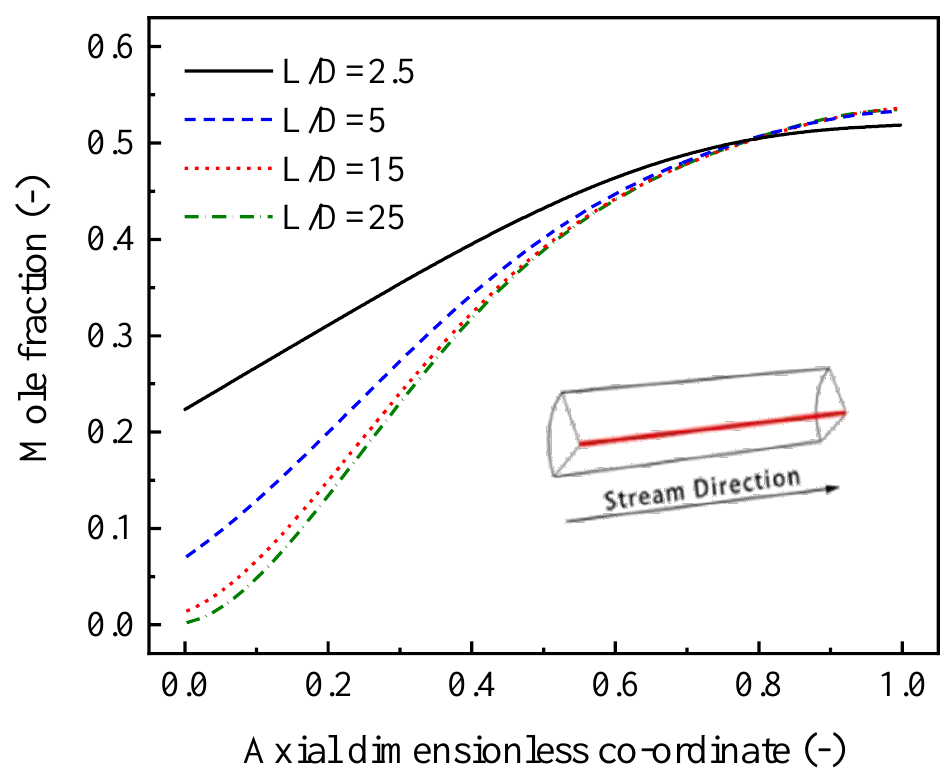
Figure 14. Molar fraction of hydrogen along the central axis of the tube-type channel (100,000 mL/g-cat/h).